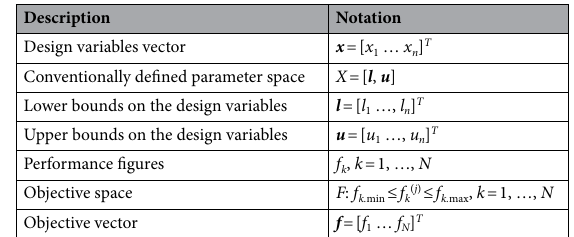
Table 1. Constrained modeling: basic object